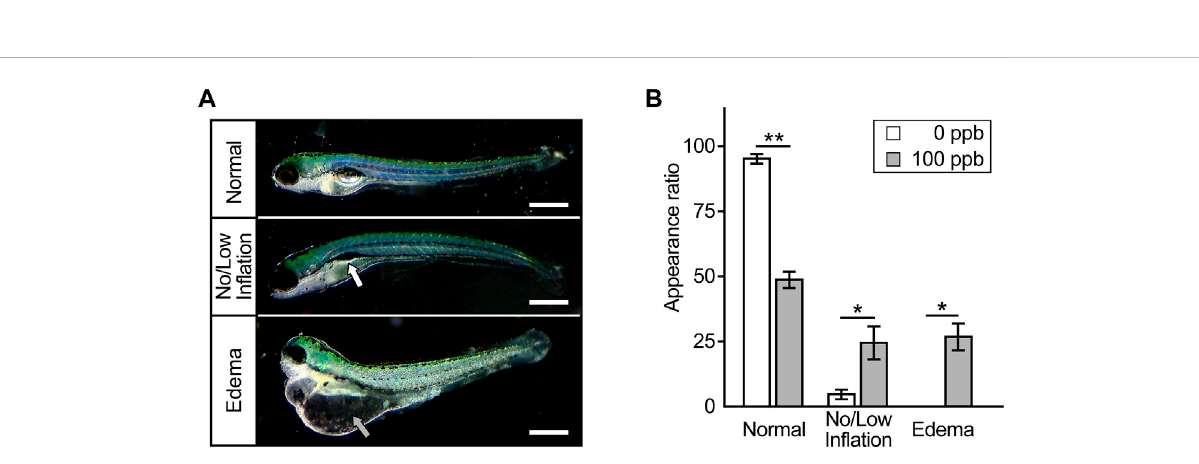
Anomalies appeared later indevelopment. (A) Typicalmicroscopic images ofzebra fi sh larvae at7dpf that wereexposed to Pbduring 6 – 72hpf. Photographsarerepresentativeofthreeexperimentsandorientedanteriortotheleftanddorsaltothetop.Scalebar=500 μ m.Whiteandgrayarrow indicates incompletely in fl ated swim bladder and edema, respectively. (B) The appearance rate (%) of in fl ation defects of swim bladder and edema is shown in the bar graph representing the mean ± SD. Statistical signi fi cance between control and Pb-exposed groups at each time point was calculated by the Student ’ s t-test. * p < 0.05, ** p <